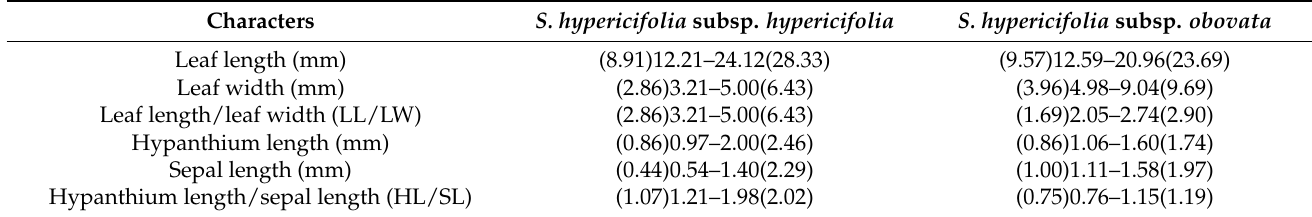
Table 1. Comparison of diagnostic morphological characters based on studied herbarium material between S. hypericifolia subsp. hypericifolia and S. hypericifolia subsp. obovata . Characters are reported as 10–90 percentiles (extreme values in